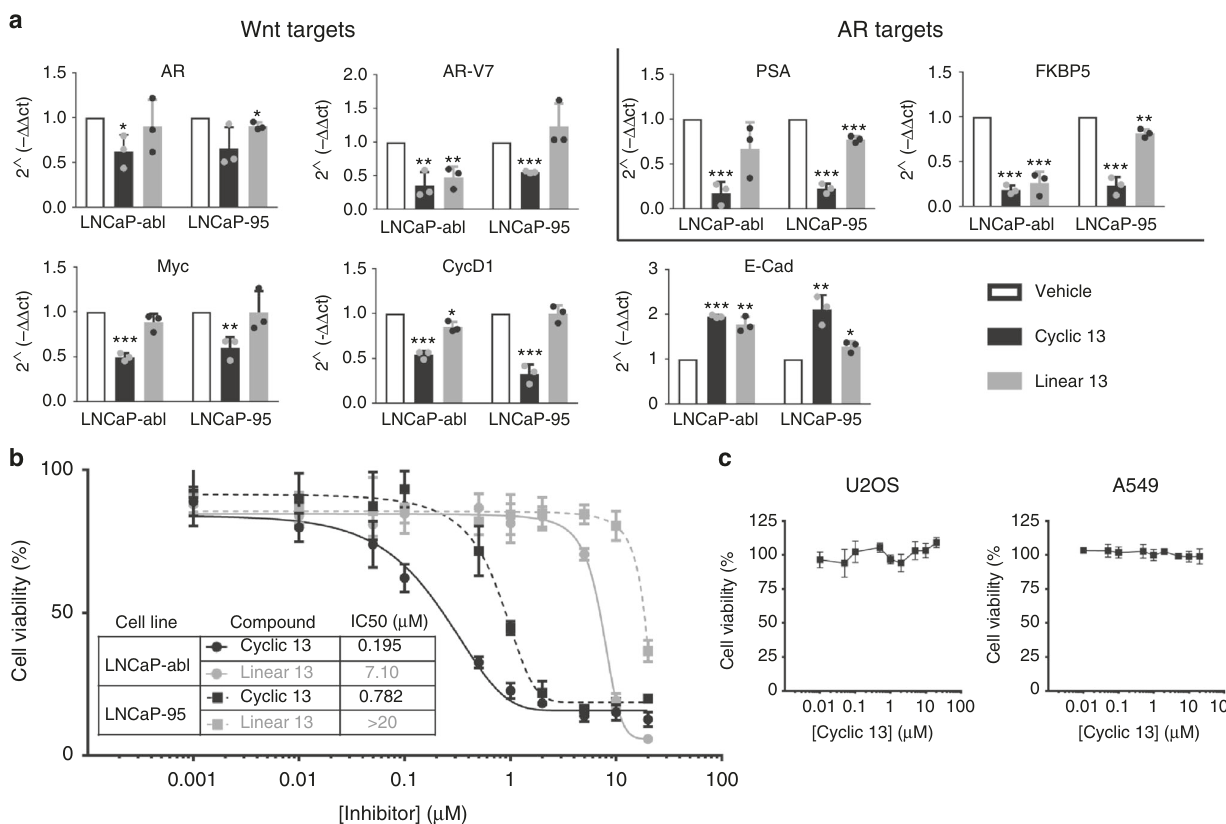
Fig. 4 Macrocycle 13 affects prostate cancer cell lines. a RT-qPCR of mRNA collected from LNCaP-abl or LNCaP-95 cells treated with 10 µ M 13 (black) or 10 µ M linear 13 (grey) oligomer for 24 h. b Cell viability measurements using CellTiter-Fluor reagent with 5 day oligomer treatment in prostate cancer cell lines. c Cell viability measurements with cyclic 13 in two non-prostate, Wnt-independent cell lines. Data are presented as mean and SD ( n = 3) of three independent experiments ( a ) or representative of three independent experiments ( b , c ). Statistical differences for RT-qPCR were calculated by unpaired t - tests, * p < 0.05, ** p < 0.01, *** p <